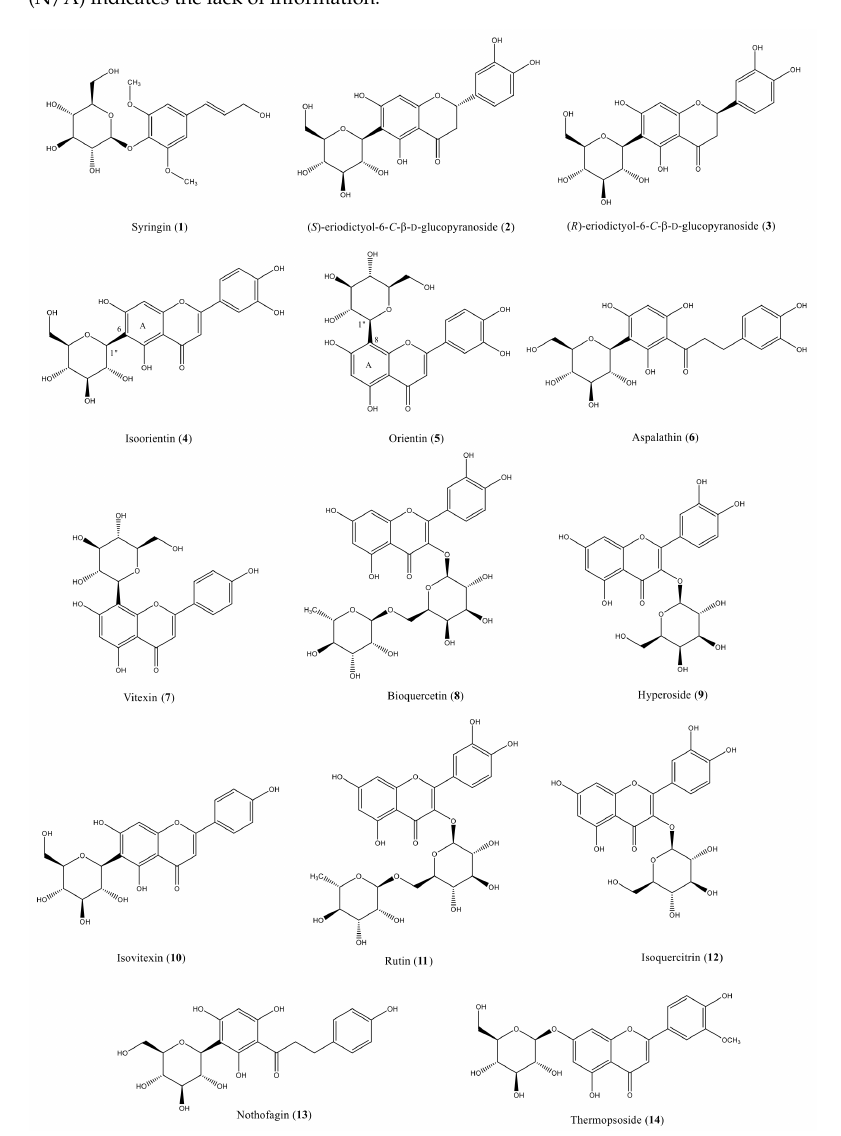
Figure 1. Chemical structures of isolated phytoconstituents 1 – 14 from A. linearis